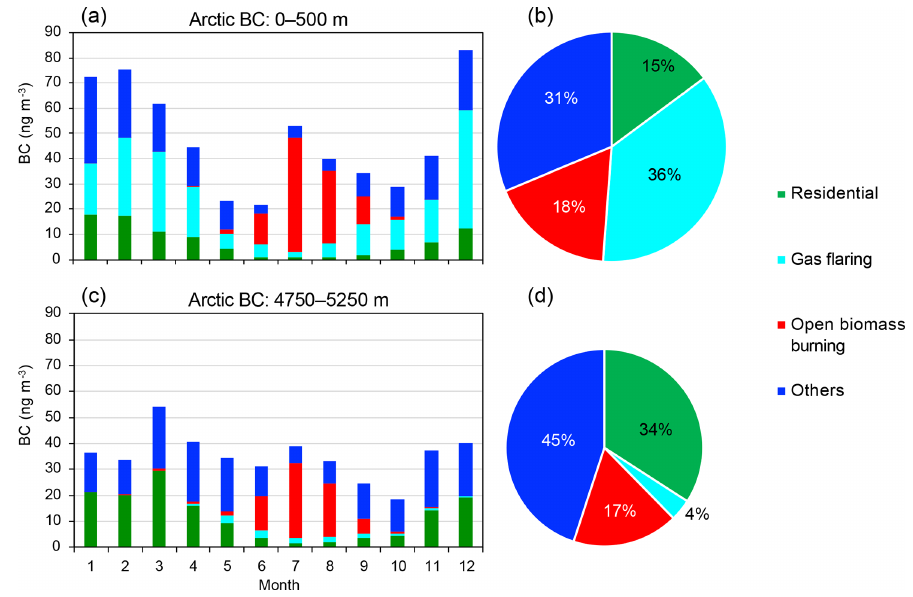
Figure 5. Sectorial contributions from residential combustion (including fossil fuel and biofuel combustions), gas flaring, open biomass burning and others (energy other than gas flaring, industry, and transport) to (a) seasonal variations in Arctic surface BC, (b) annual mean Arctic surface BC, (c) seasonal variations in Arctic BC at high altitudes, and (d) annual mean of Arctic BC at high altitudes.